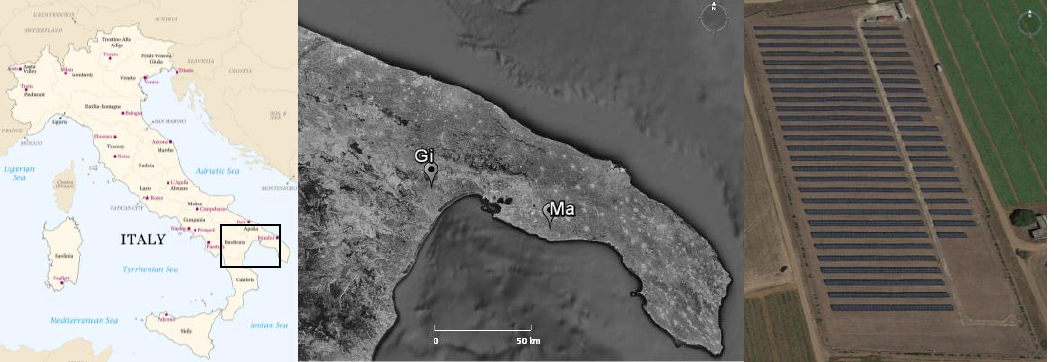
Figure 1. Location of the two grid-connected PV systems and satellite photo of the “Gi” site.